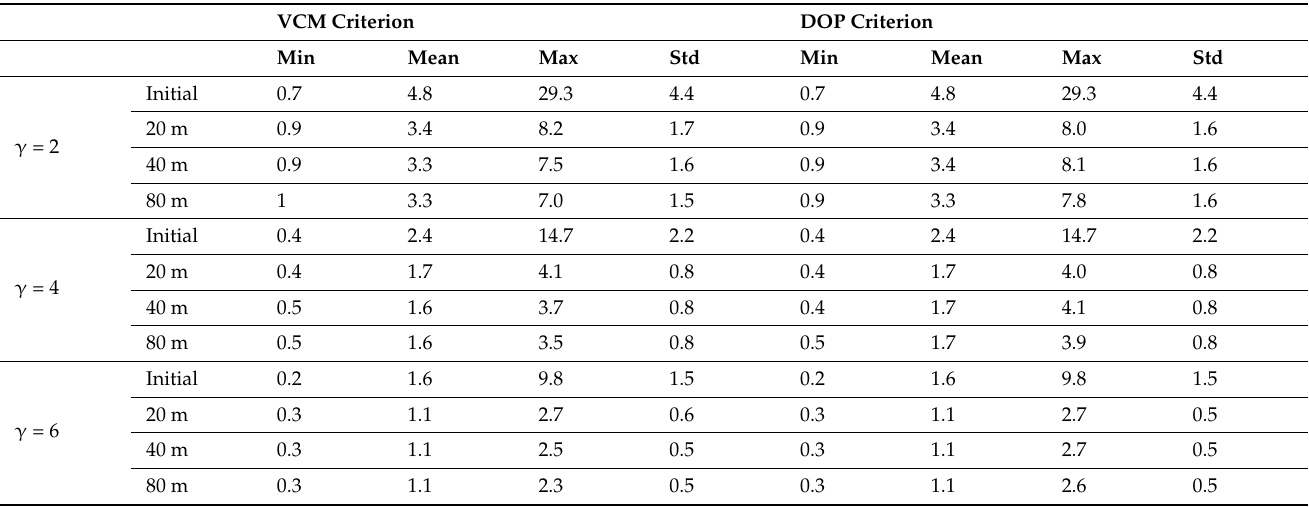
Table 2. Dilution of precision (DOP) before and after optimisation based on the VCM and DOP criteria and different values of γ .